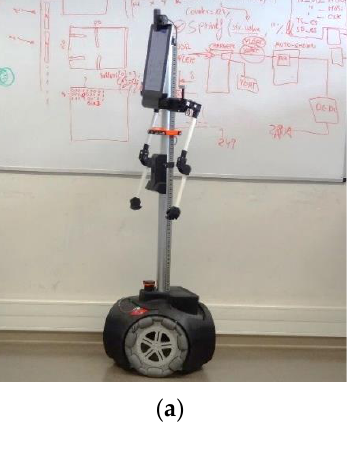
Figure 1. ( a ) Image of the APR-02 mobile robot. ( b ) Details of the internal structure supporting the three BDCMs that drive the three omnidirectional wheels of the mobile robot. three BDCMs that drive the three omnidirectional wheels of the mobile